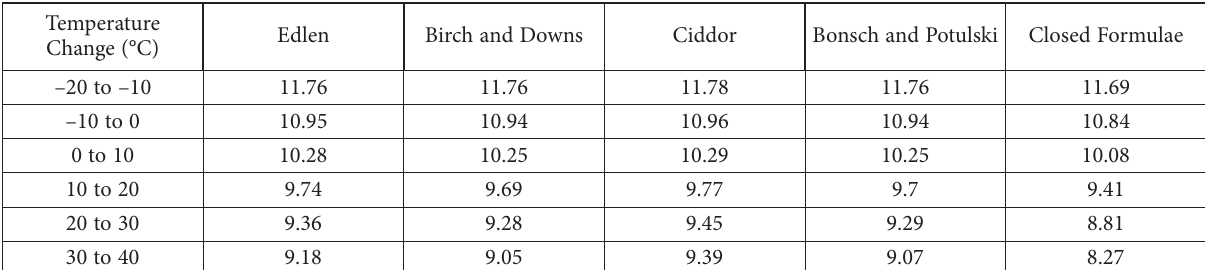
Table 1. EDM corrections in every 10 °C interval (ppm)